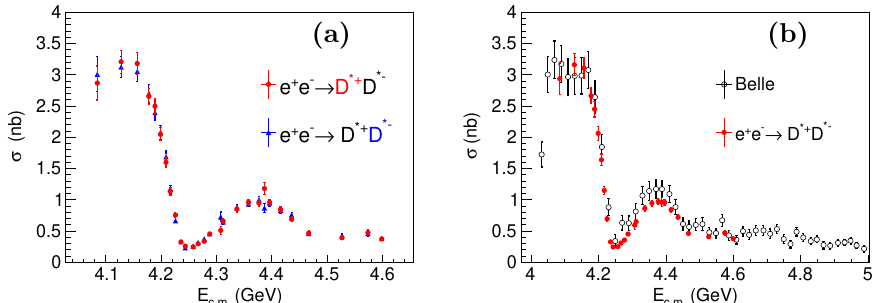
Figure 4. (a) The Born cross sections of e + e − → D ∗ + D ∗− as a function of the c.m. energy for the reconstructed D ∗ + (red dots) and D ∗− candidates (blue triangles). (b) The comparison of the aver- age cross sections for e + e − → D ∗ + D ∗− between this work (red dots) and those of the Belle experi- ment [21] (black circles). Error bars are the quadratic sum of statistical and systematic